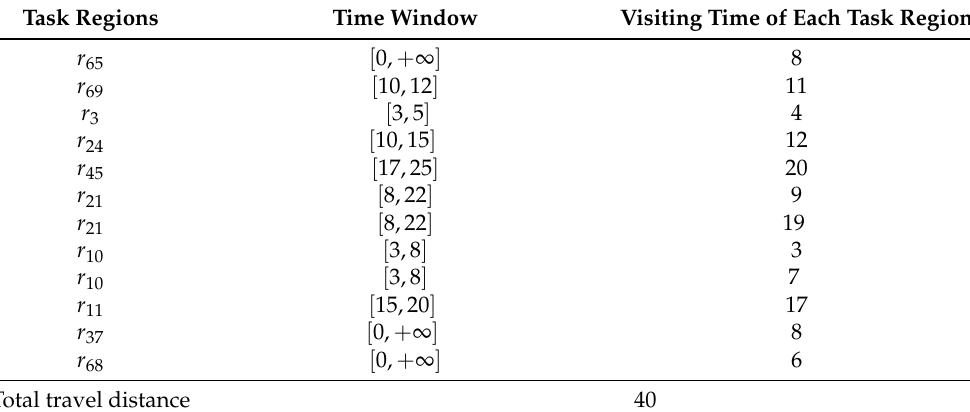
Table 2. Visiting time of each task